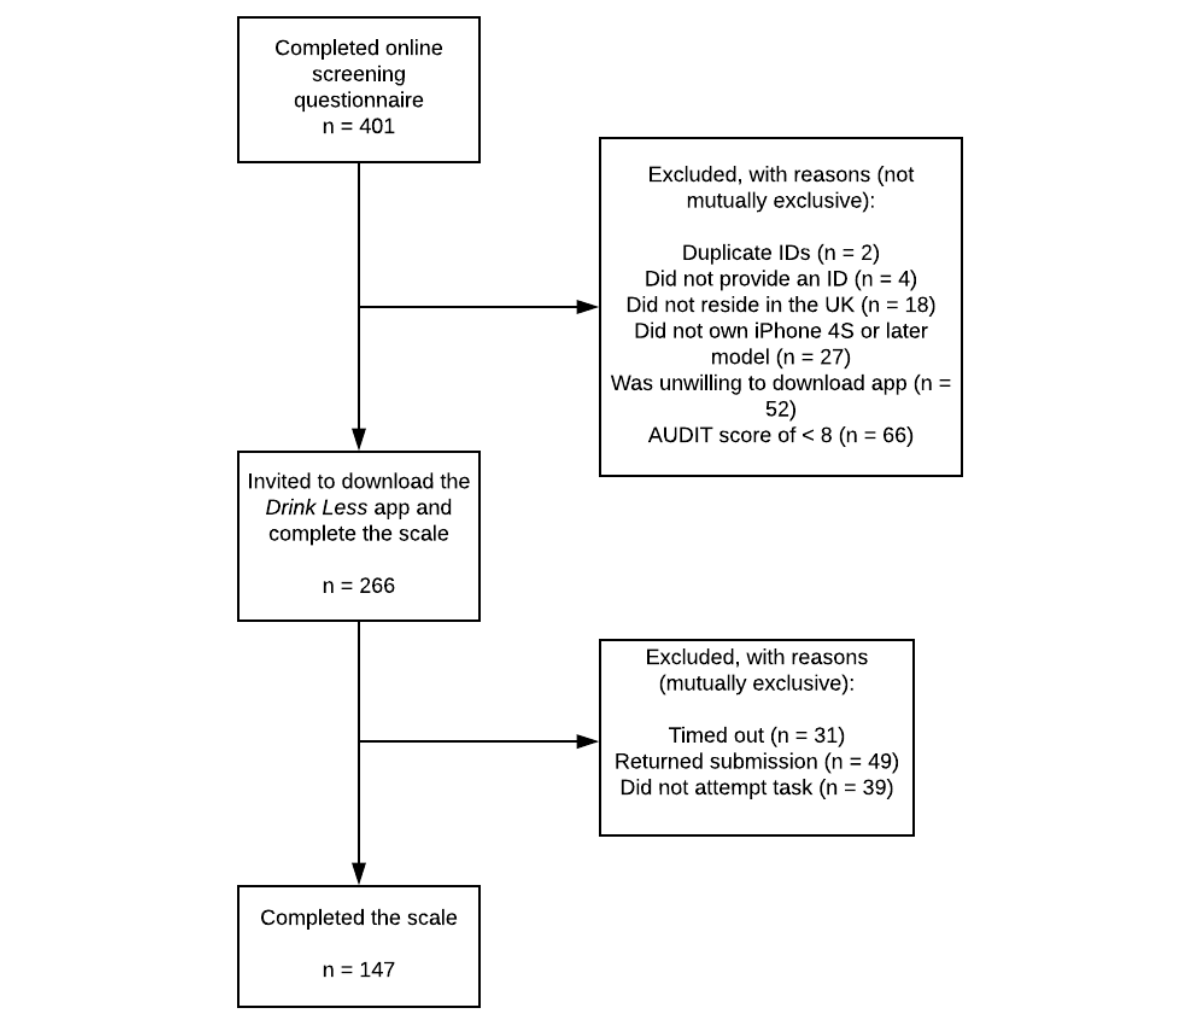
Figure 1. Participant flow chart. AUDIT: Alcohol Use Disorders Identification Test; ID: